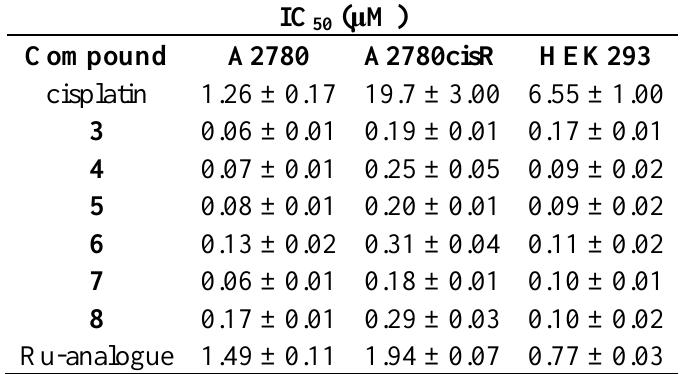
3. IC values of metalla-rectangles 3 – 8 and the 50